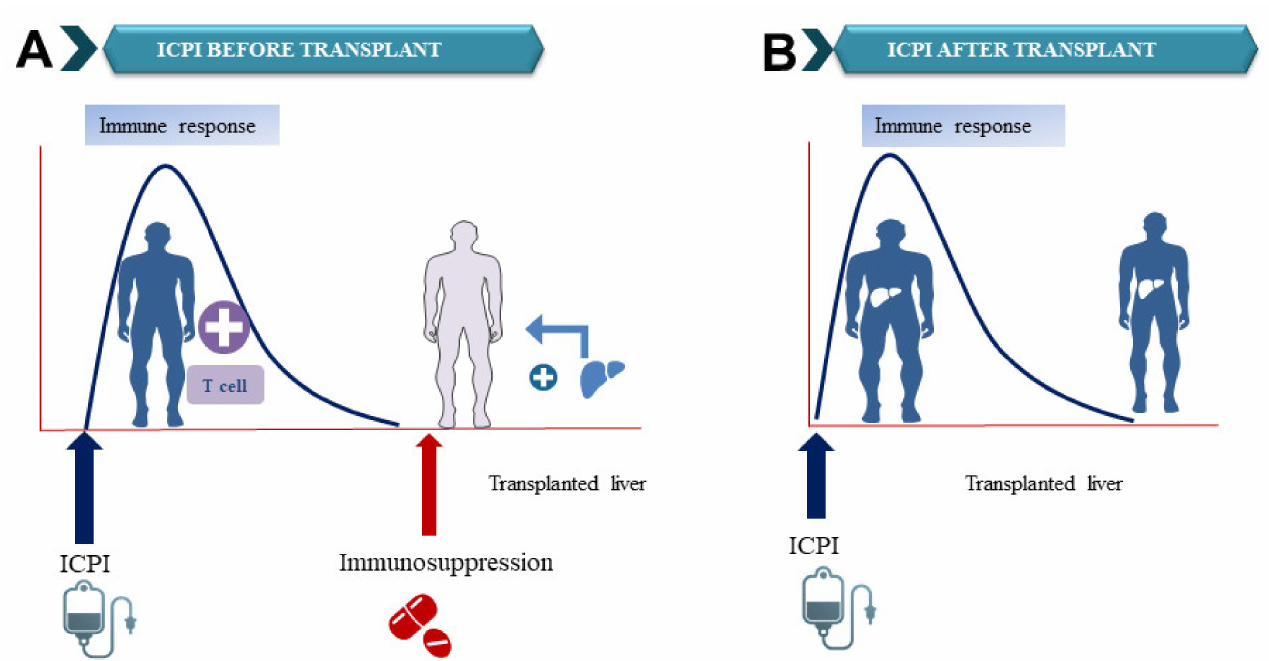
Figure 2. The expected timeline for using Immune checkpoint inhibitors in liver transplantation patients with HCC. ( A ) ICPI will free the immune system and active T-cell to attack and kill cancer cells. This state of the “hyperactive” immune system occurs in the absence of the allograft. Once ICPI is held, the immune system will “cool off” and return gradually to the normal body immune state at which a new liver transplant can be achieved safely.( B ) ICPI can be used post-transplant to treat cancer recurrence or new second primary cancer. In this setting, the immune system will be activated in the presence of the graft, so the risk of graft rejection will be higher at around 30% than the general